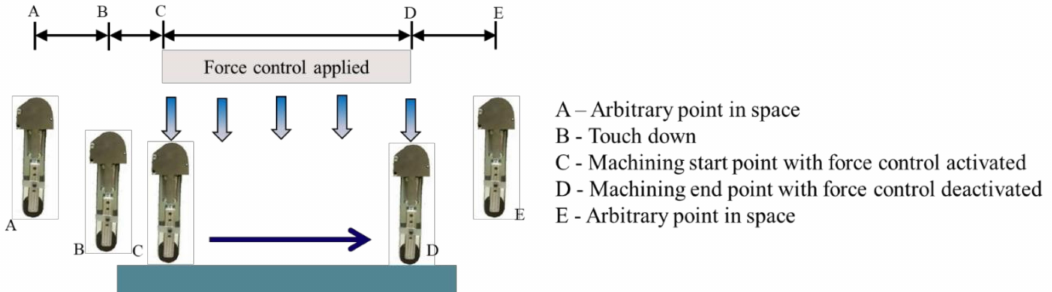
Figure 14. Abrasive tool path on the mild-steel